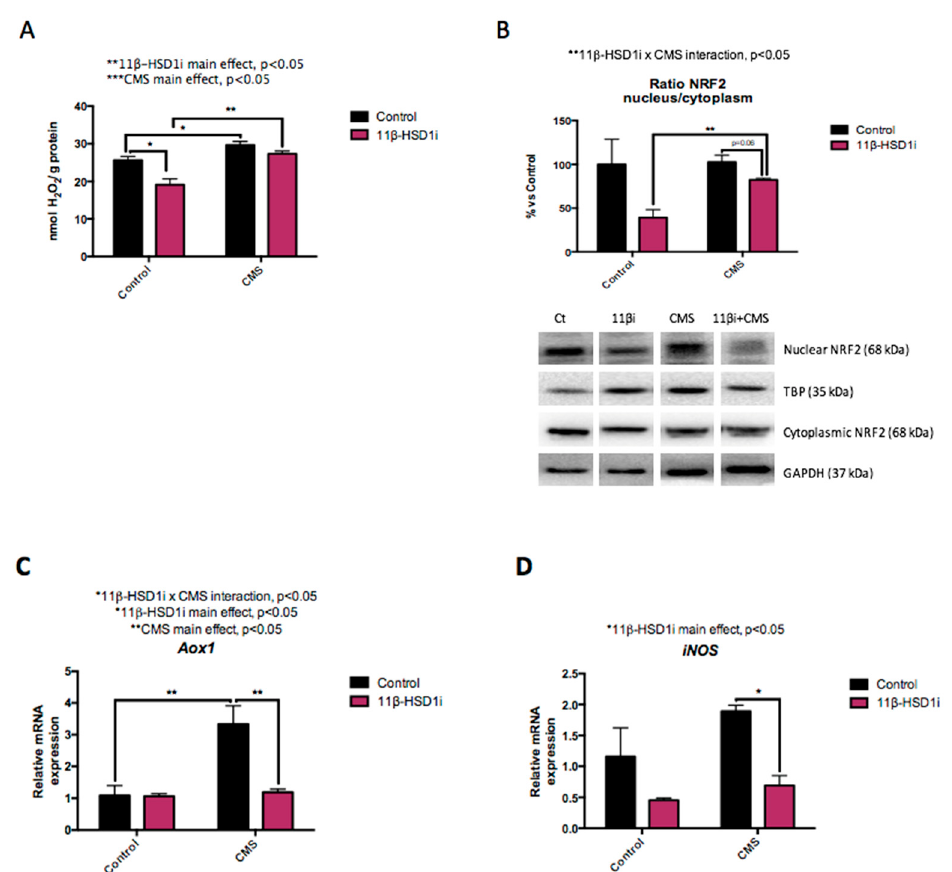
Figure 3. Representative results from pro-oxidant vs. antioxidant mechanism imbalances. Representative ROS accumulation was measured by the hydrogen peroxide concentration in homogenates of hippocampus tissue ( A ). Representative Western blot for the ratio of nuclear/cytoplasmic NRF2 protein levels and quantification ( B ). Relative gene expression of Aox1 ( C ) and iNOS ( D ). Western blot values in bar graphs are adjusted to 100% for protein levels of SAMP8 Control (Control). Gene expression levels were determined by real-time PCR. Values are mean ± standard error of the mean (SEM) ( n = 6 for each group). 11 β -HSD1 and CMS main effects as well as interactions were determined. * p < 0.05; ** p <